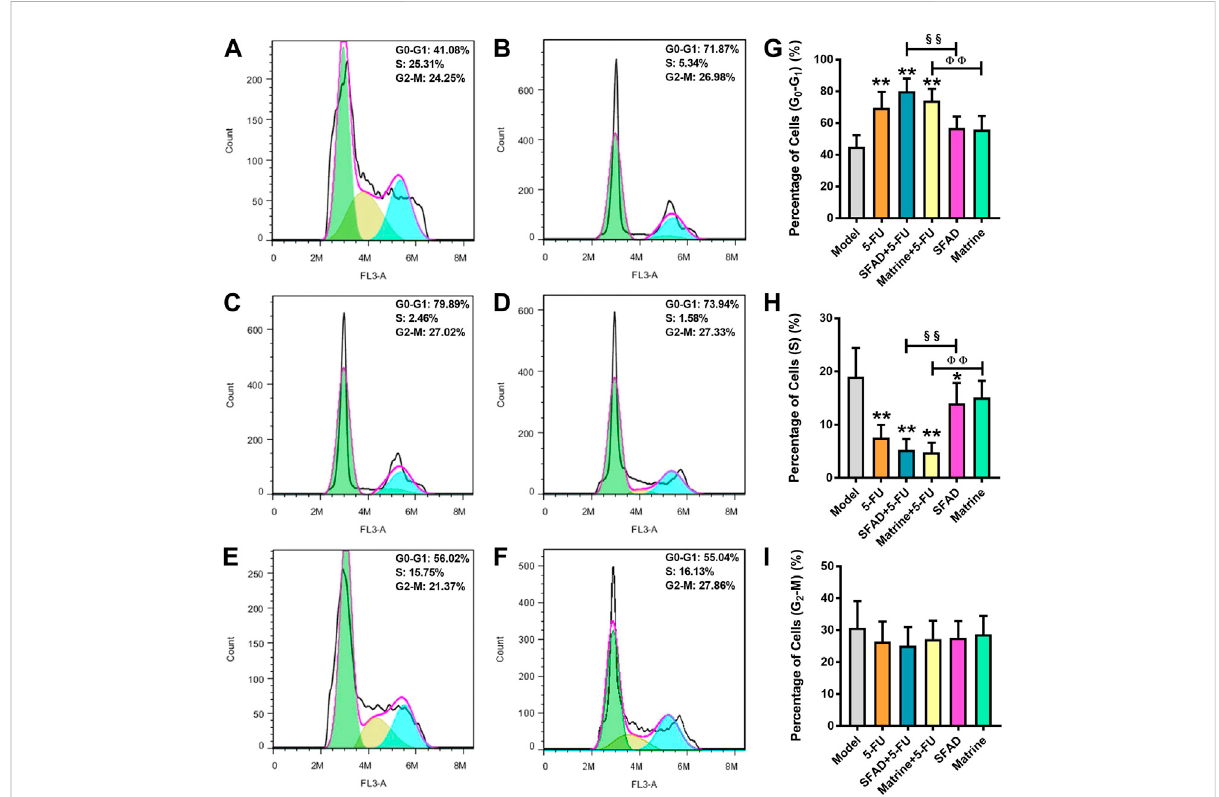
FIGURE 5 Effects of SFA/matrine+5-FU on the tumor cell cycle in BGC-823-transplanted nude mice. (A) Model control (negative control). (B) 5-FU control (0.01 g/kg) (positive control). (C) SFAD (0.2 g/kg)+5-FU (0.01 g/kg). (D) Matrine (4.03 mmoL/L)+5-FU (0.01 g/kg). (E) SFAD (0.2 g/kg). (F) Matrine (4.03mmoL/L). (G) Proportion oftumorcells intheG 0 -G 1 stage (gap phase). (H) Proportionoftumor cells intheSstage (synthesisphase). (I) Proportion of tumor cells in the G 2 -M stage (gap phase 2-mitotic phase). Data are presented as the mean ± SD of eight nude mice. * p < 0.05, ** p < 0.01vs.themodelgroup; §§ p < 0.01fortheSFAD+5-FUvs.SFADgroups; ΦΦ p <